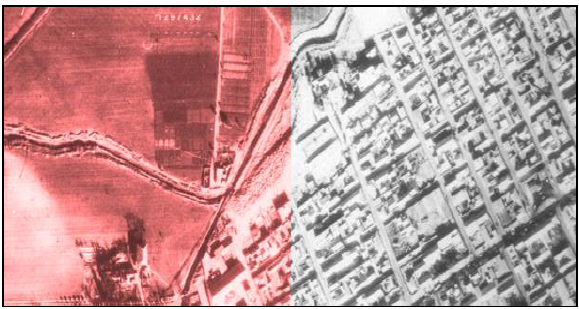
Figure 12. Continuity of details on orthoimages after